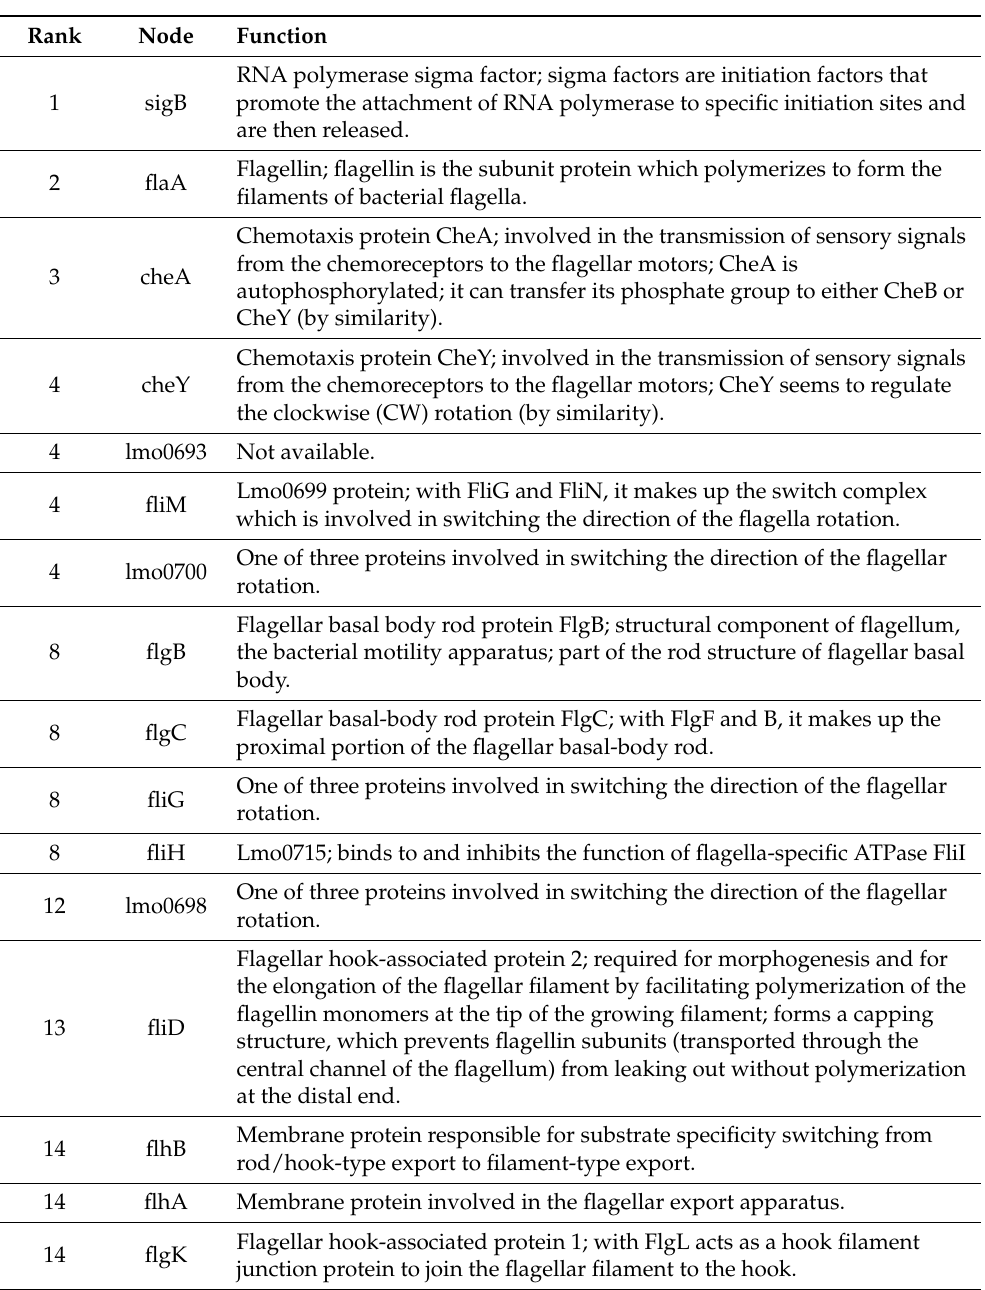
Table A5. Summary of top 17 nodes for antibiotic